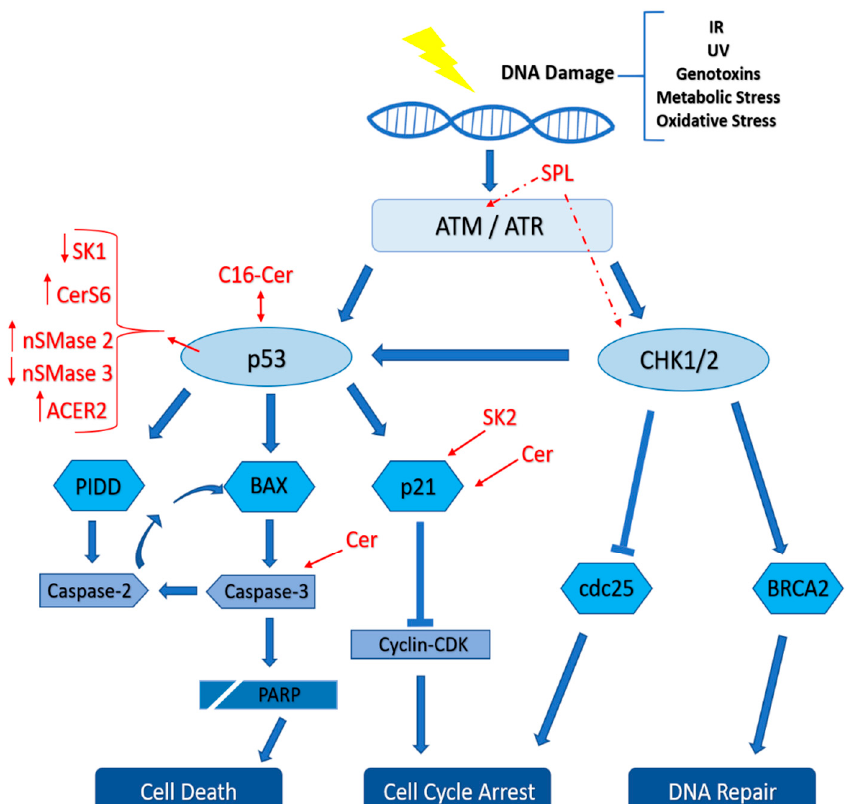
Figure 2. Interplay between DNA damage response (DDR) and sphingolipids to shape cell fate after DNA damage. After genotoxic injury, the DDR develops to sense the damage and amplify the transmitted signaling cascade. The transiently activated cell cycle arrest allows DNA repair. However, persisting unrepaired damage triggers cellular senescence or death to hinder damage propagation to the next generation of cells. The sphingolipid metabolism interacts mainly with p53 along with other elements of the DDR to determine the injured cell fate. ACER2: alkaline ceramidase 2, Cer: ceramide, CerS: ceramide synthase, nSMase: neutral sphingomyelinase, SK: sphingosine kinase, SPL: S1P lyase, double-headed arrow: interaction and activation, full arrow: upregulation and activation, and dashed arrow: downregulation.